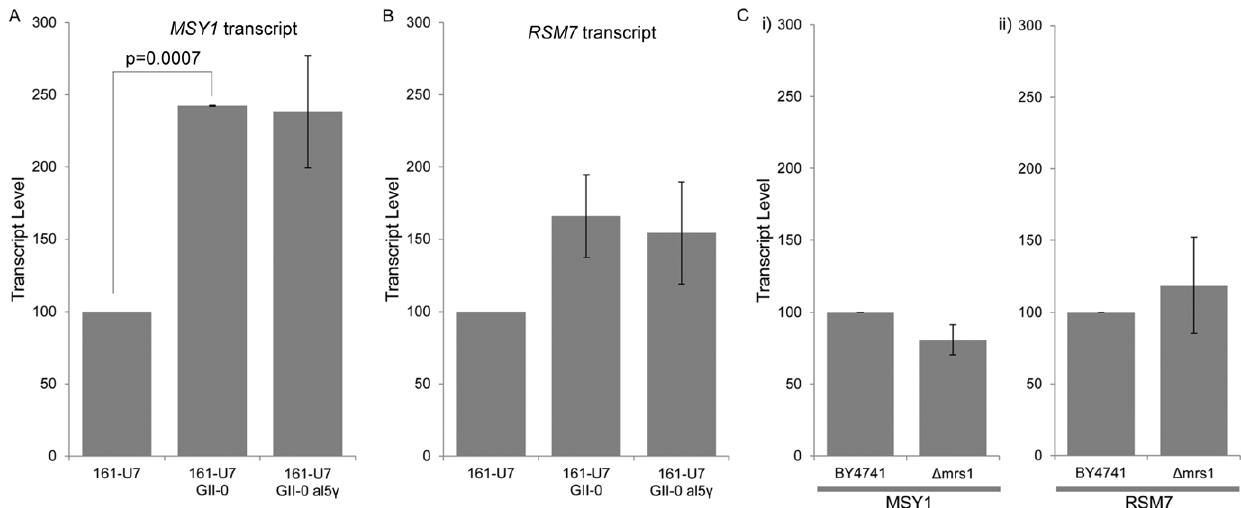
Figure 5. Knocking out mitochondrial encoded reverse transcriptase activity results in increased transcript levels of nuclear genes that are involved in Mito-nDNA interactions. A) Nuclear encoded MSY1 transcript levels were determined by qRT-PCR in WT (strain 161-U7), 161-U7 GII-0 (lacks both the mitochondrial group II introns and the COX1 interacting region; Figure 4A), and 161-U7 GII-0 a15 c (contains the interacting region and lacks the group II introns; Figure 4A) cells. B) Nuclear encoded RSM7 transcript levels were determined by qRT-PCR in: WT (strain 161-U7); 161-U7 GII-0; and 161-U7 GII-0 a15 c cells. Neither 161-U7 GII-0 nor 161-U7 GII-0 a15 c has any alteration within the Q0182 open reading frame. C) Deletion of MRS1 (BY4741 D mrs1 ), a nuclear gene involved in splicing mitochondrial type-I introns, has no effect on i) MSY1 or ii) RSM7 transcript levels. All transcript levels were standardized to nuclear ACT1 and expressed as percentage of wild-type (set at 100%) + / 2 standard error of the mean